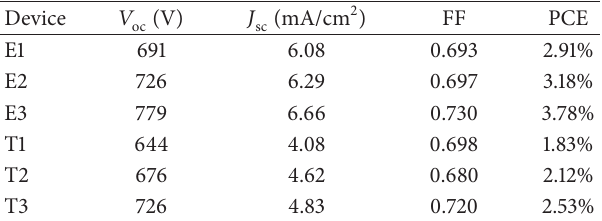
Table 2: Photovoltaic performances of PT1–3 dyes in different adsorption solutions.